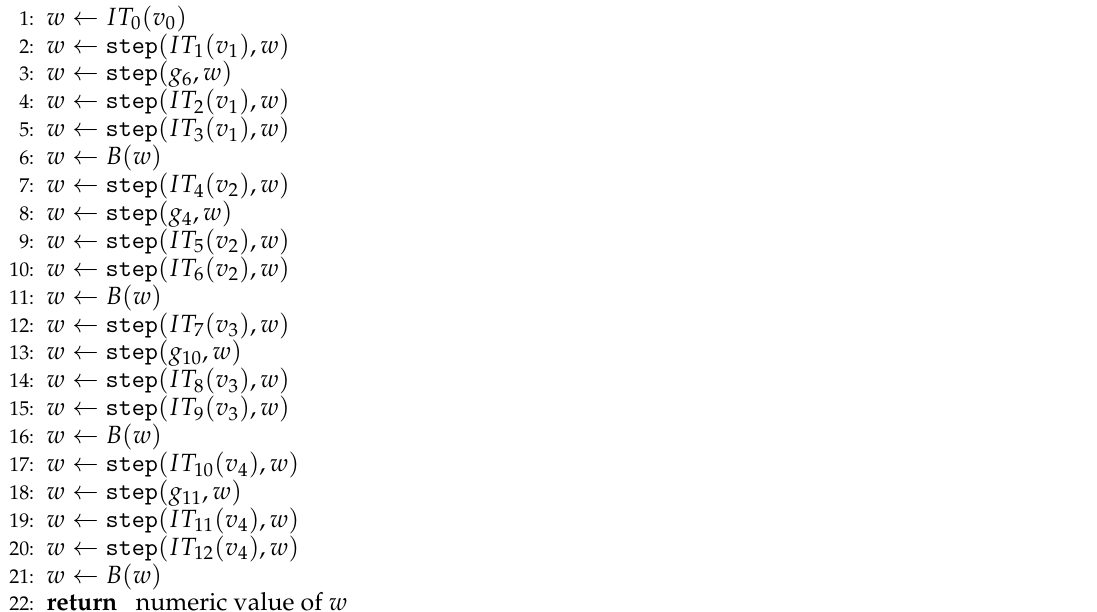
Algorithm A3 Public program (obfuscated